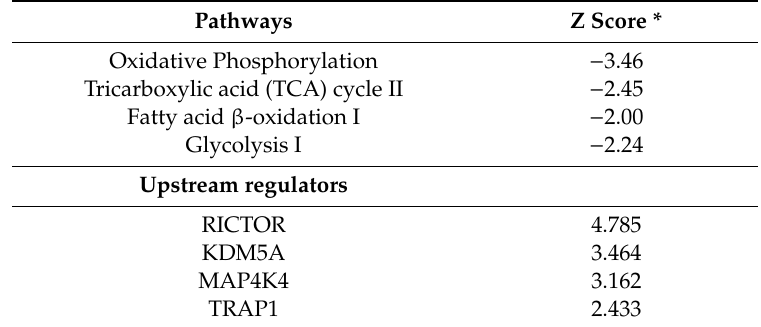
oxidative phosphorylation and Sirtuin signaling pathway, protein ubiquitination pathway, tricarboxylic acid (TCA) cycle II, isoleucine degradation I, acetyl-CoA biosynthesis and tRNA charging are the top canonical pathways a ff ected in cancer group. Table 3. Deactivated pathways and upstream regulators a ff ected in spermatozoa of cancer